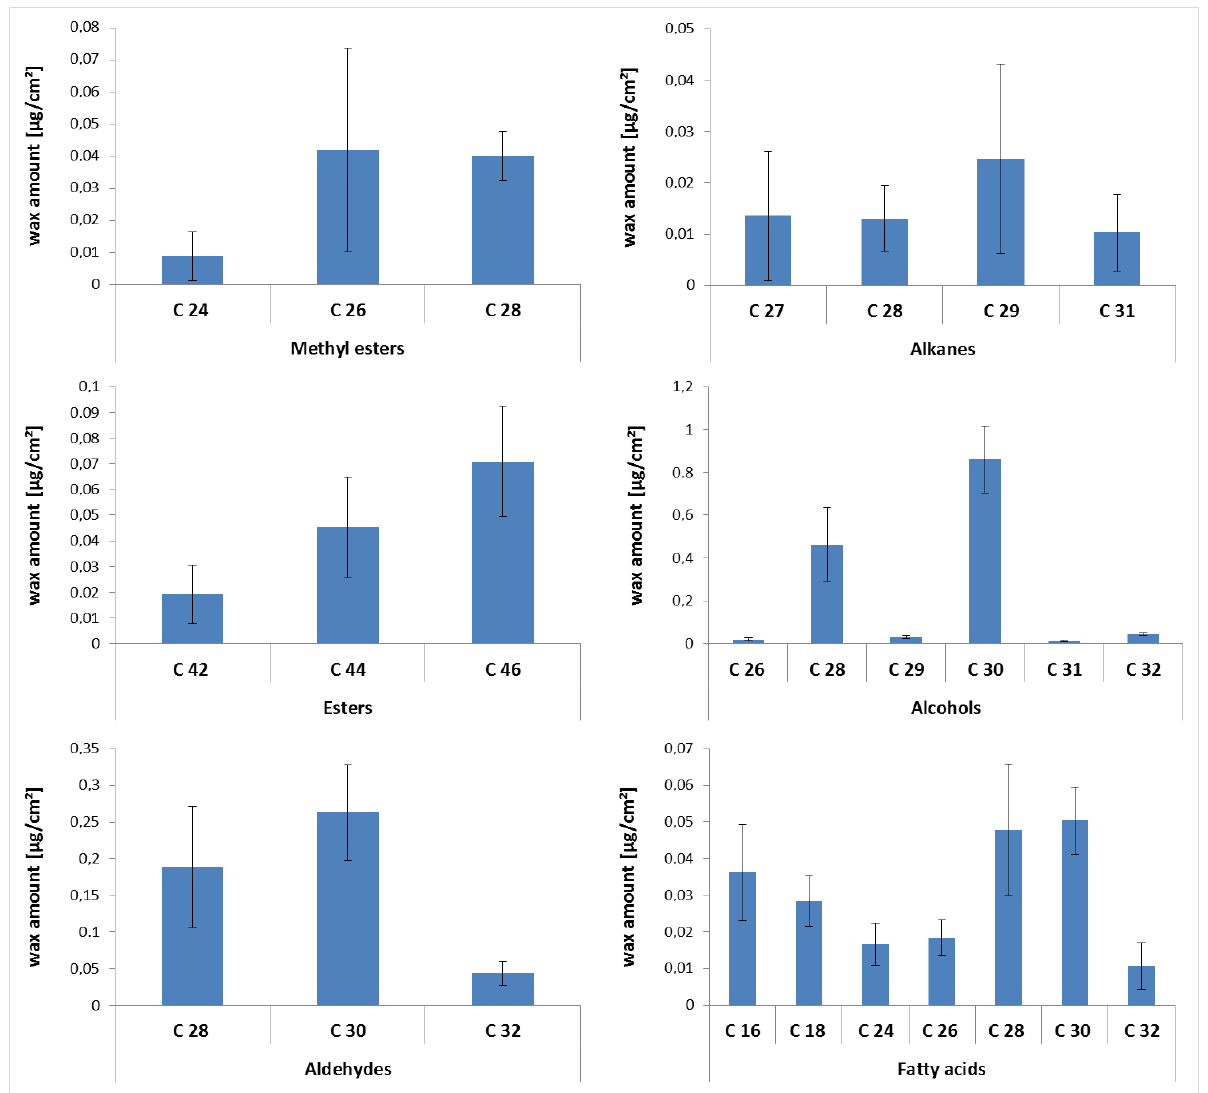
Figure 3: Chemical composition of soybean leaf wax divided by substance class. Wax was extracted by dipping the leaves for 10 s in pure chloro- form. Bars represent the mean ( n = 4) ± standard deviation.